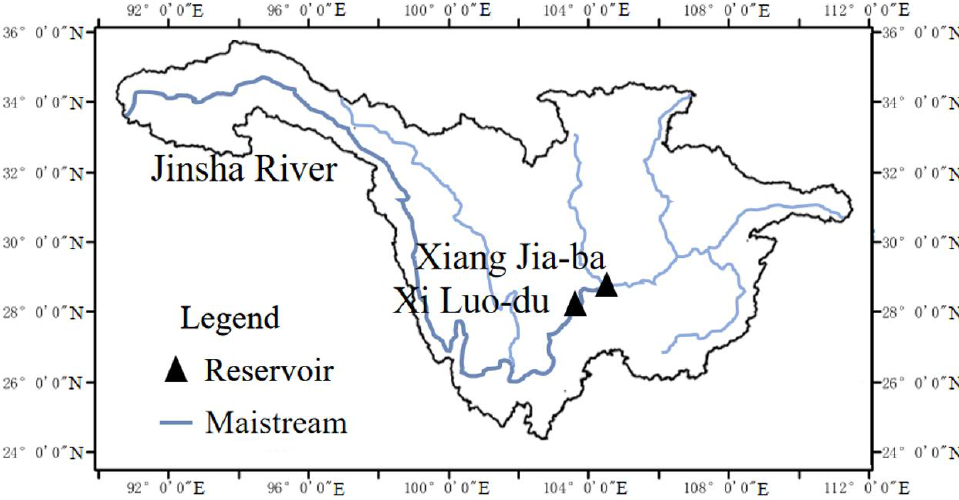
Figure 1. Location of the cascade reservoirs including the Xi Luo-du Reservoir and Xiang Jia-ba reservoir in the upper Yangtze River.